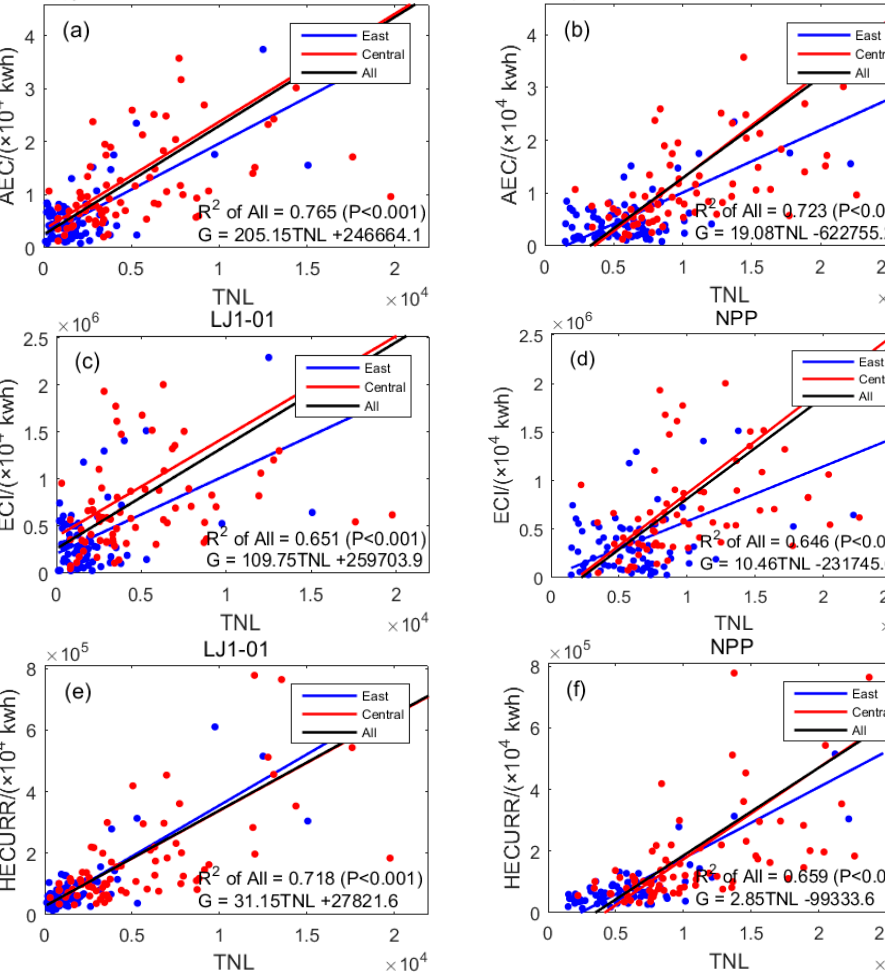
Figure 5. Scatter diagrams for linear regression results of electricity consumption and TNL: ( a ) TNL of LJ1-01 data and AEC; ( b ) TNL of NPP/VIIRS data and AEC; ( c ) TNL of LJ1-01 data and ECI; ( d ) TNL of NPP/VIIRS data and ECI; ( e ) TNL of LJ1-01 data and HECURR; ( f ) TNL of NPP/VIIRS data and HECURR.